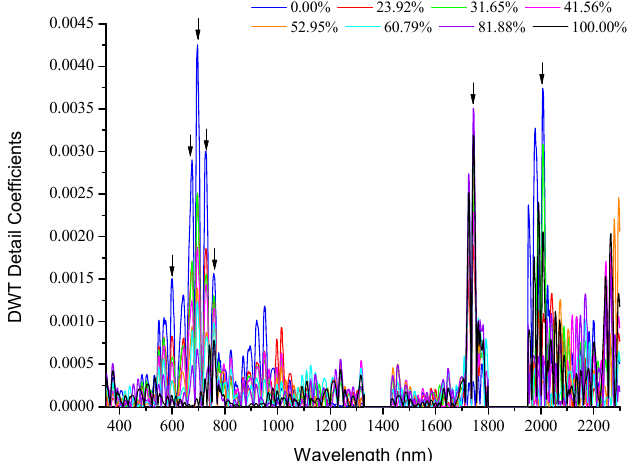
Figure 8. Absolute value of the fifth-level detail coefficient of the wavelet-transformed reflectance spectra of samples with different oil-polluted area fractions (expressed as percentages in the legend).